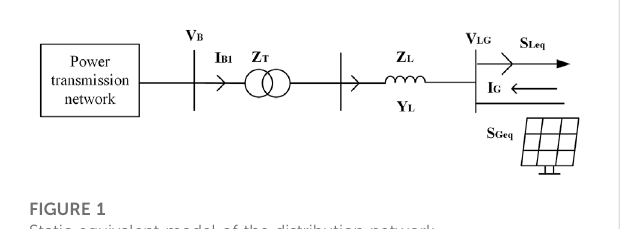
FIGURE 1 Static equivalent model of the distribution